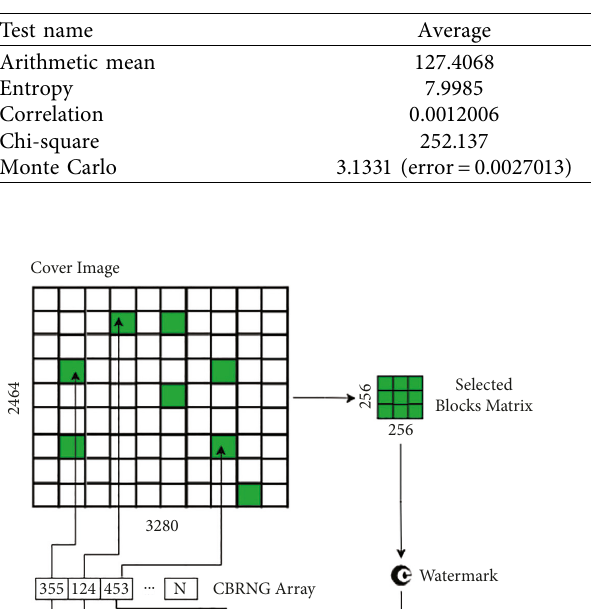
Table 2: ENT test results of random numbers obtained from x output.